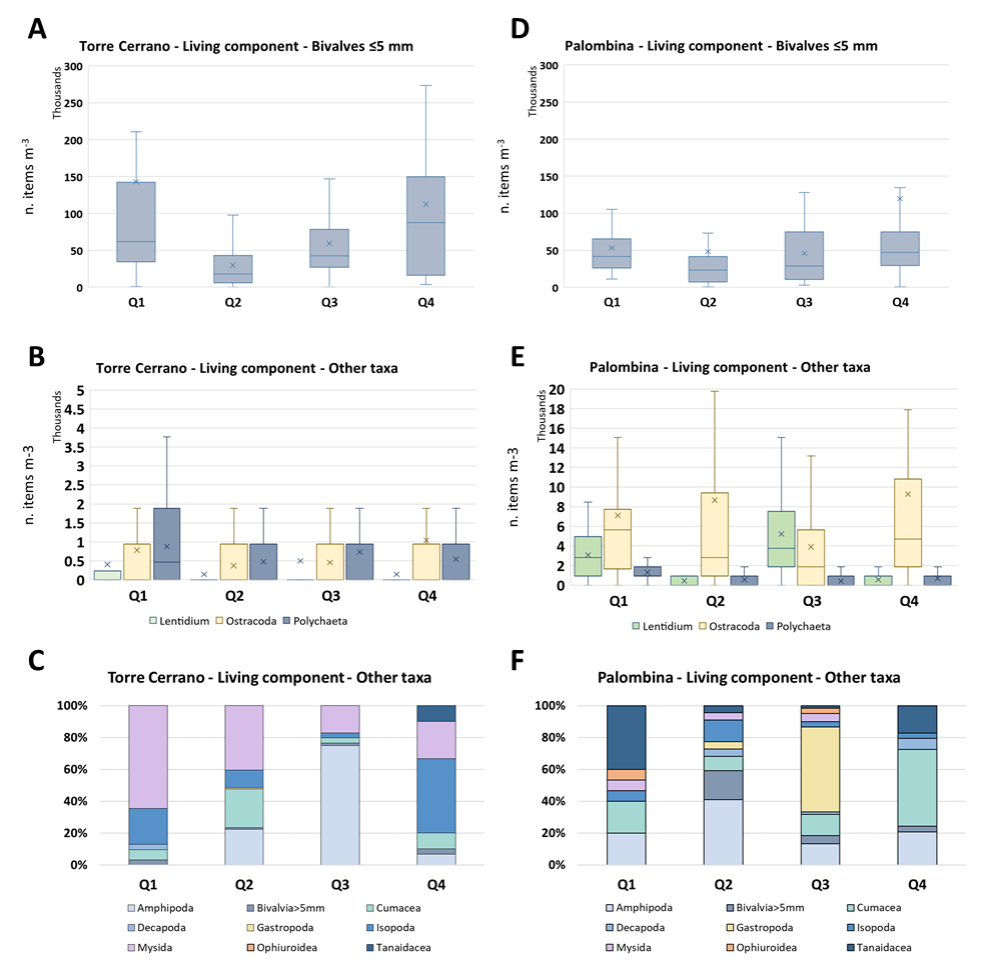
Figure 2. Temporal variations in abundance (n. items m − 3 ) of the living component (macrofaunal taxa) in the sediments collected in Torre Cerrano MPA ( A – C ) and Palombina ( D – F ). Only Bivalves ≤ 5 mm were showed in ( A , D ), because their high abundance values would have overwhelmed the other taxa. ( B , E ) Abundance of ostracods, Lentidium mediterraneum , and polychaetes. ( C , F ) Percent composition of less represented taxa. Outliers not showed.